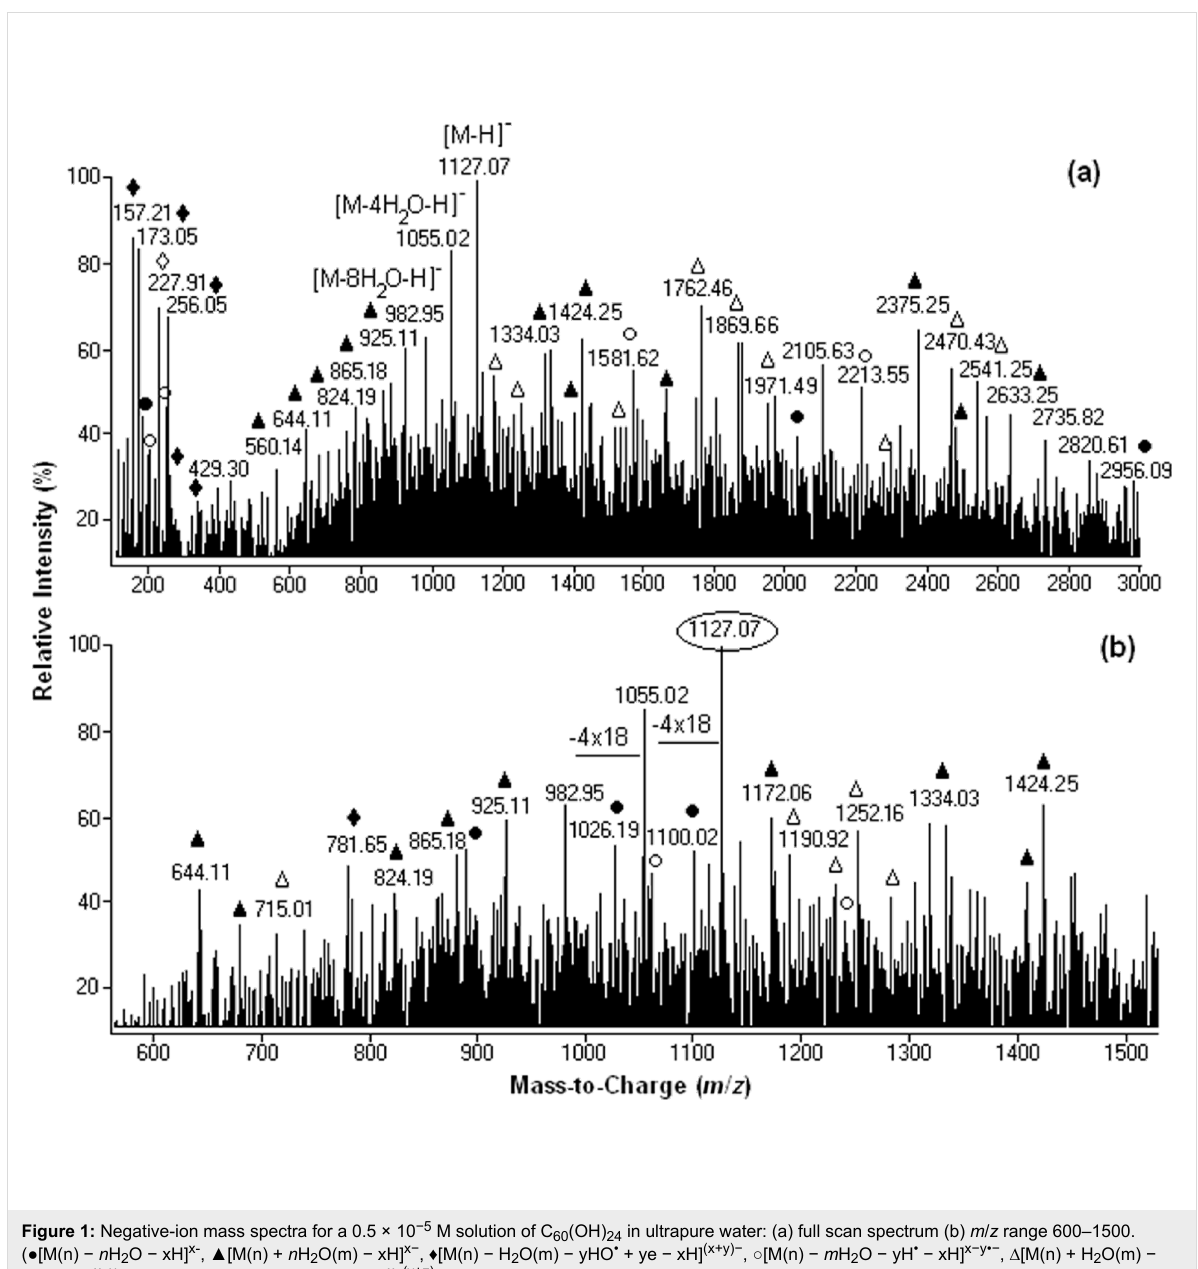
Figure 1: Negative-ion mass spectra for a 0.5 × 10 − 5 M solution of C 60 (OH) 24 in ultrapure water: (a) full scan spectrum (b) m / z range 600–1500. ( ● [M(n) − n H 2 O − xH] x- , ▲ [M(n) + n H 2 O(m) − xH] x − , ♦ [M(n) − H 2 O(m) − yHO • + ye − xH] (x+y) − , ○ [M(n) − m H 2 O − yH • − xH] x − y• − , ∆ [M(n) + H 2 O(m) − yH • − xH] x − y• − , ◊ [M − m H 2 O − yHO • − zH • − xH] x − (y+z)• −